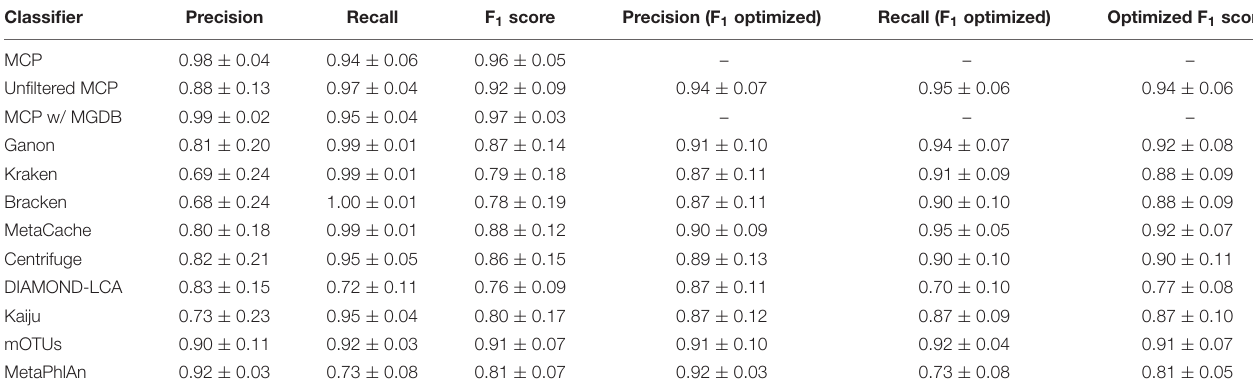
TABLE 4 | Evaluation of classifiers to predict the presence or absence of species across the 140 mock communities with and without optimizing the F 1 score (mean ± std. dev.). Classifier Precision